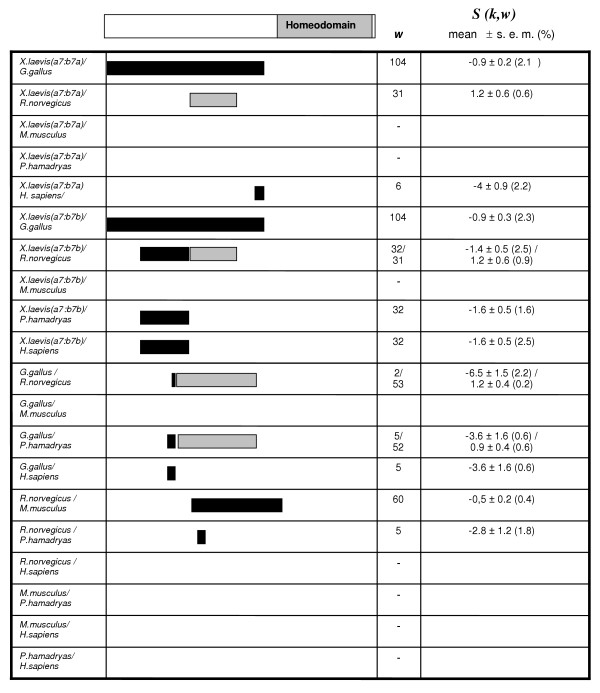
Distribution of significant results in the 20 Hox-a7-Hox-b7 comparisons. Grey: significant positive S(k, w) values (the duplicates of the first named species are the most conserved), Black: significant negative S(k, w) values (the second species has the most conserved duplicates). w: window size.